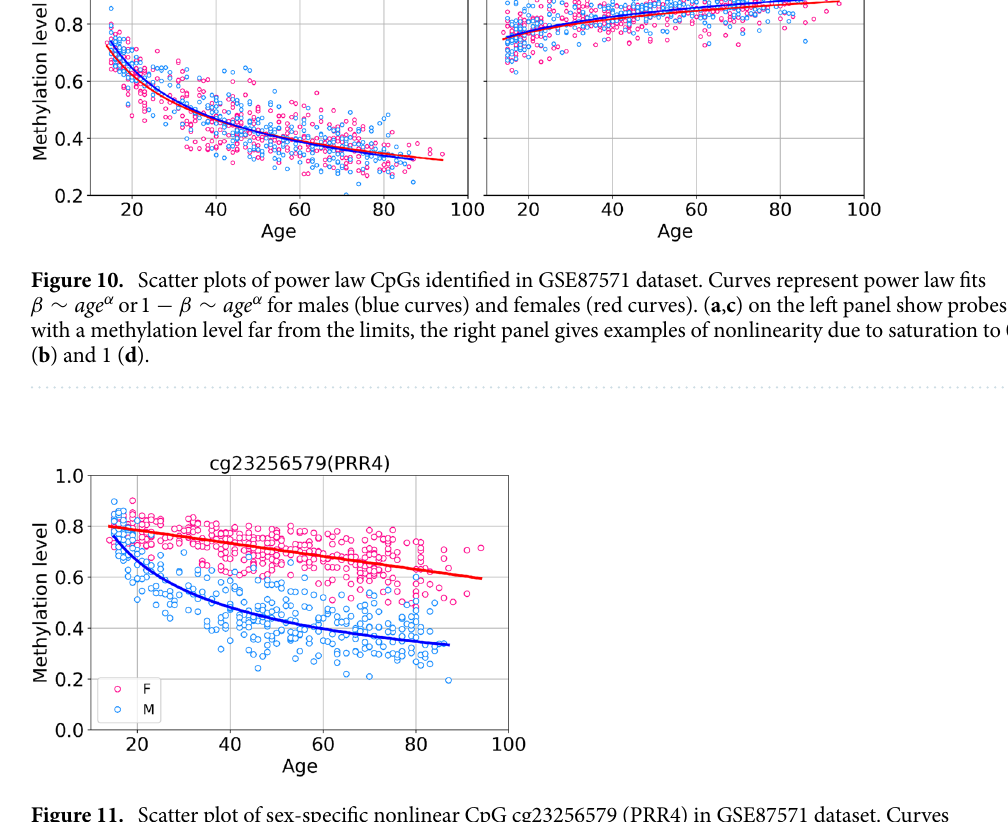
Figure 11. Scatter plot of sex-specific nonlinear CpG cg23256579 (PRR4) in GSE87571 dataset. Curves represent power law fit for males (blue curve) and linear fit for females (red curve).